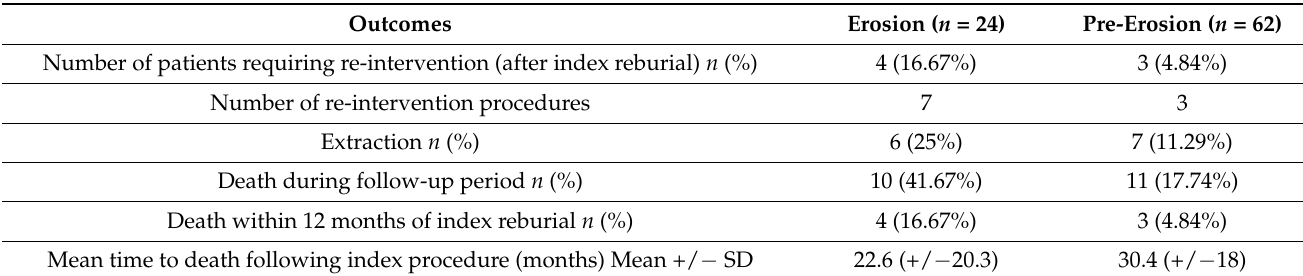
Table 2. Outcomes.